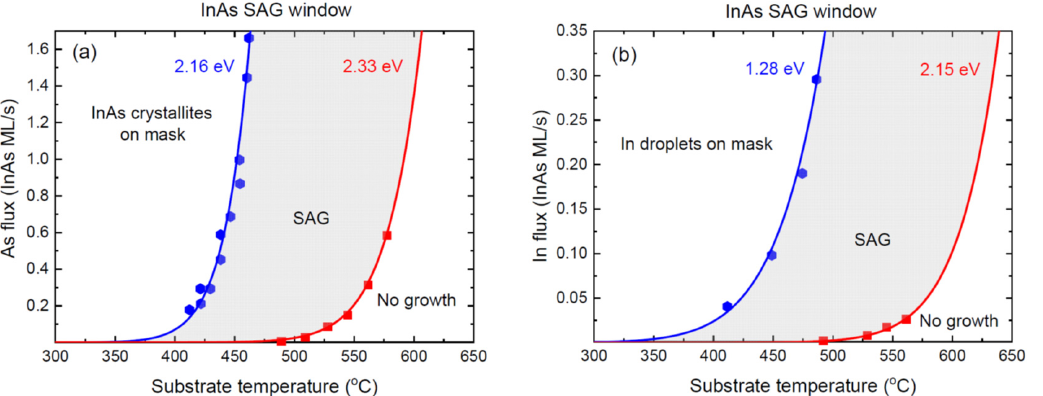
Figure 5. Same as Figure 4 for heteroepitaxial InAs SAG on GaAs(100). Symbols represent the datapoints of Ref. [26]. The lines correspond to the maximum and minimum fluxes obtained from Equation (24) with the effective activation energies shown near each curve.